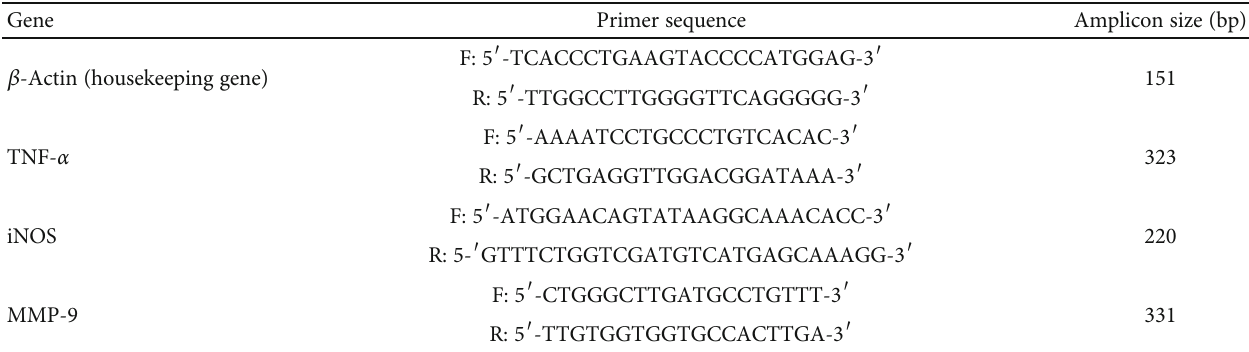
Table 1: The forward and reverse primer sequences of various mRNA